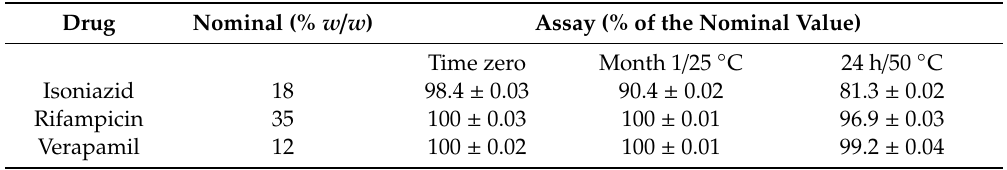
Table 1. Drugs content of the SD powder (mean value and standard deviation) at time zero and after storage for 1 month at 25 ◦ C and for 24 h under stressed condition (50 ◦